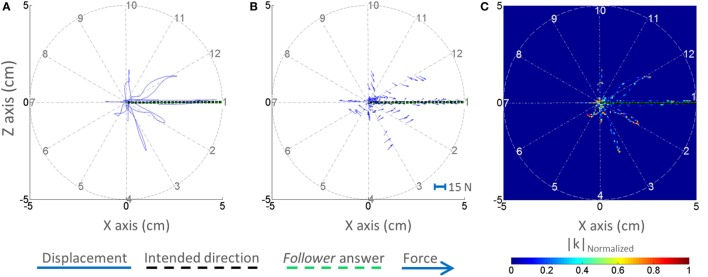
Displacement, forces, and normalized |k|–position profiles. One representative trial is shown for the dyad from the visual feedback group. The displacement–position profile is shown in panel (A). The force–position profile (quiver plot) is shown in panel (B). The normalized |k|–position profile is shown in panel (C). The selected trial is representative of correct response.